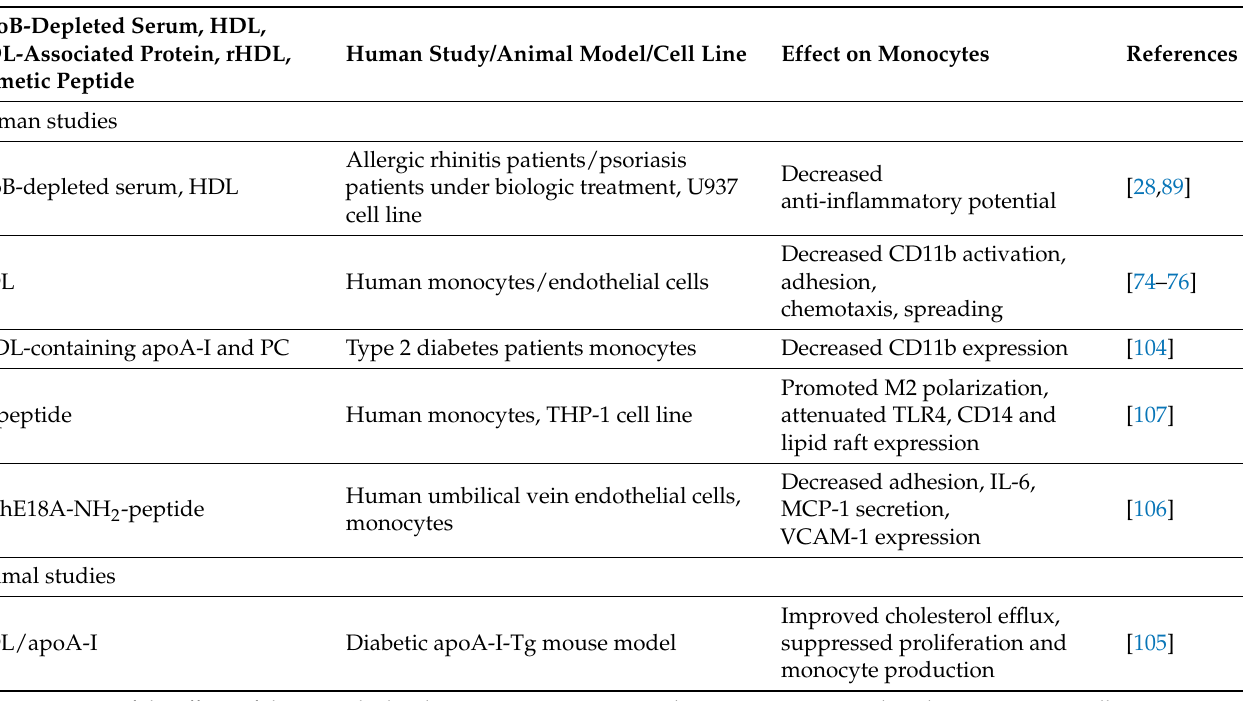
Table 1. Effects of apoB-depleted serum, HDL, reconstituted HDL, HDL-associated apolipoproteins or mimetic peptides on monocyte function in human studies utilizing primary monocytes or a monocyte cell line and in studies utilizing animal